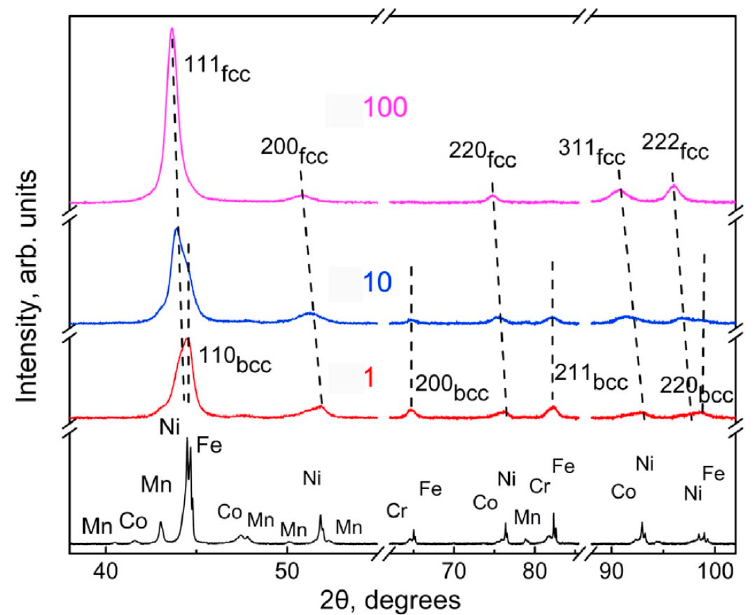
Figure 13. XRD patterns of “as-mixed” multicomponent powder (bottom curve) and CoCrFeNiMn alloys after HPT for n = 1, 10 and 100 rotations (from lower to upper curves). Tilted dashed lines indicate the changes of peak positions for fcc solid solution. Reprinted with permission from Ref. [145].